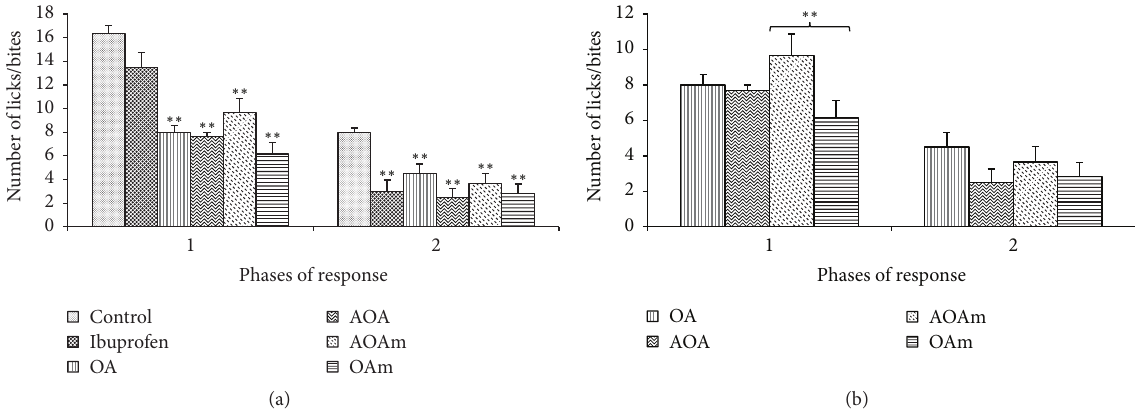
Figure 4: Formalin-induced pain behavior test. OA (oleanolic acid), AOA (3-acetyloleanolic acid), AOAm (28-methylester, 3- acetyloleanane), and OAm (28-methyloleanane). Results are presented as mean number of licks/bites ± SEM for 6 animals; ∗ 𝑝 < 0.05 and ∗∗ 𝑝 < 0.01 .(a)showsacomparisonofthetestedcompoundswithcontrolgroup,whereas(b)showsthecomparisonoftheoleananederivatives with